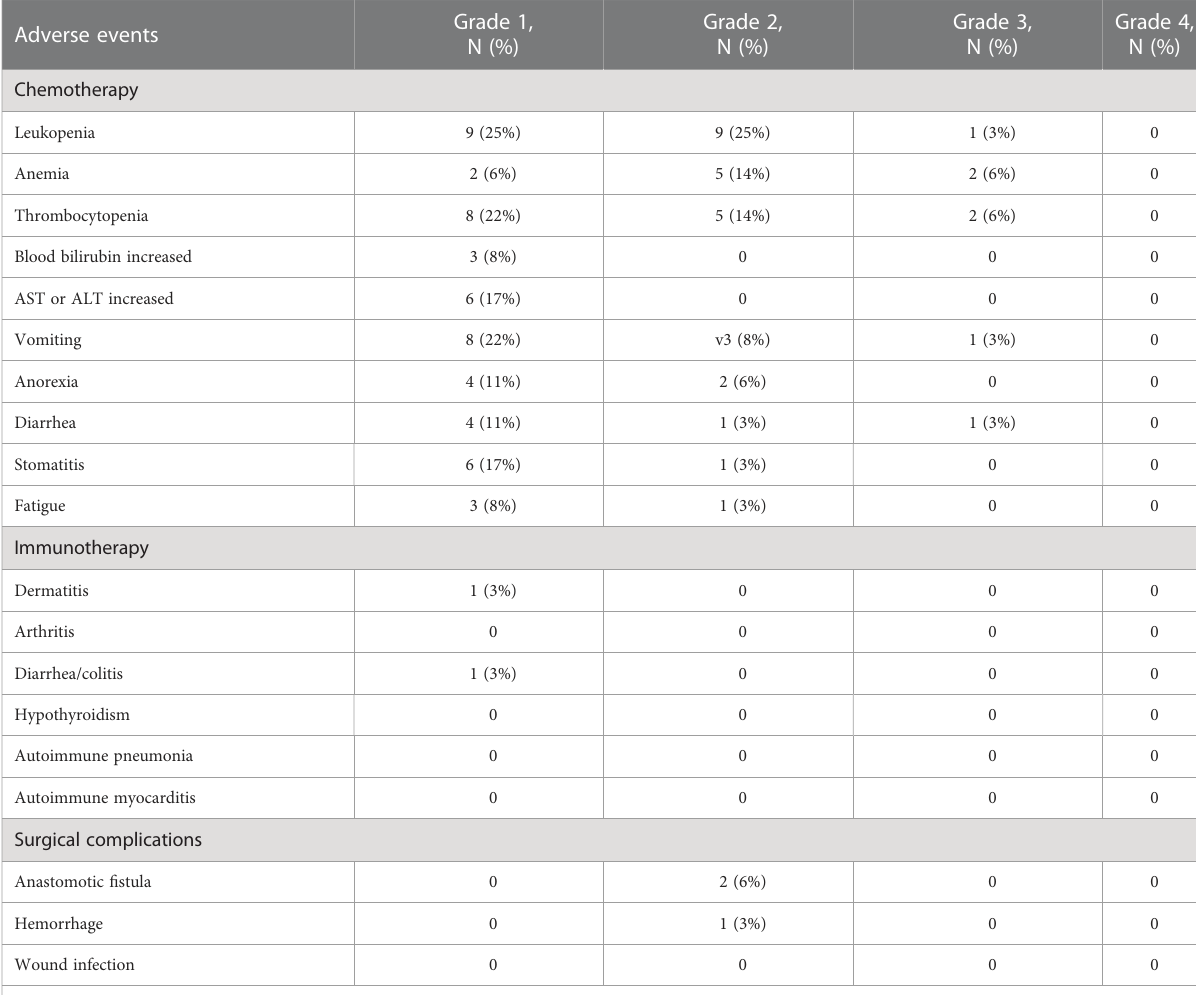
TABLE 3 Summary of adverse events and surgical